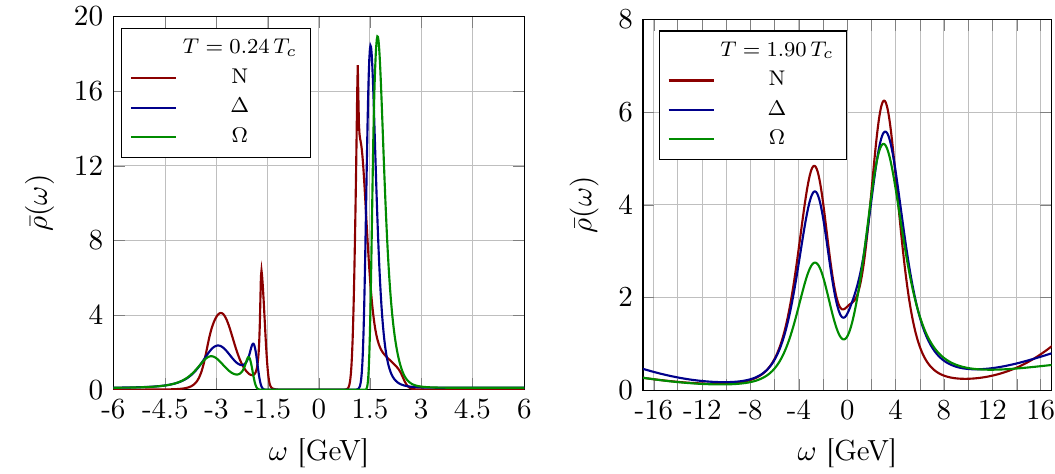
Figure 8 . Comparison between the N , (cid:1) and (cid:10) spectral functions at the lowest (left) and highest (right)